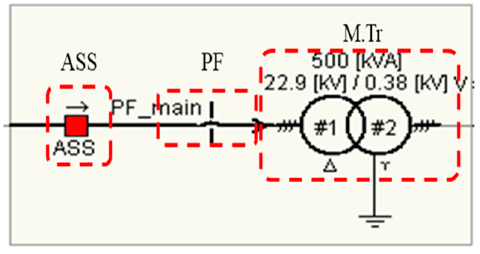
Figure 6. Modeling of switchgear section.